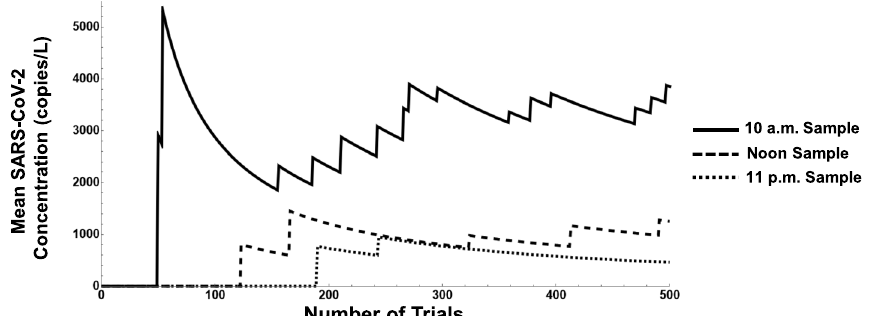
Fig. 6 Simulation output, rolling mean SARS-CoV-2 concentration (L/s) when population infection is 10%, viral load is 10 8 , and grab sample time varied